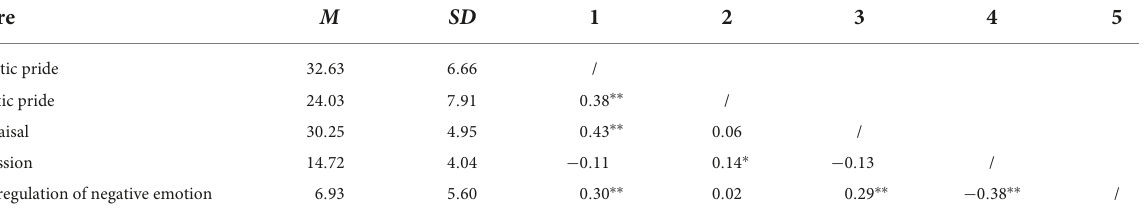
TABLE 1 Descriptive statistics and correlations among